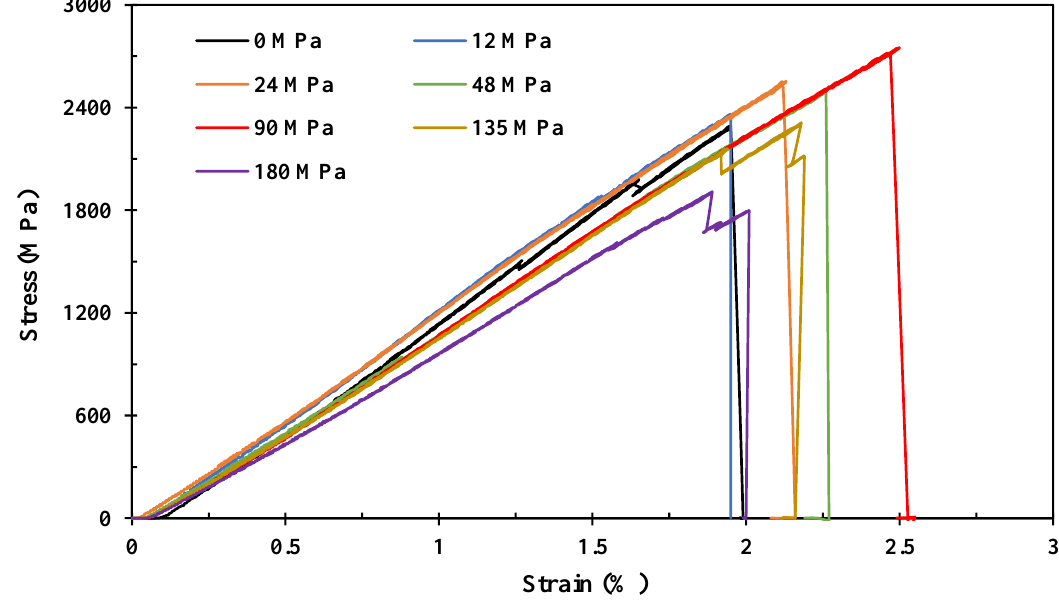
Polymers 2023 , 15 , x FOR PEER REVIEW 7 of 17